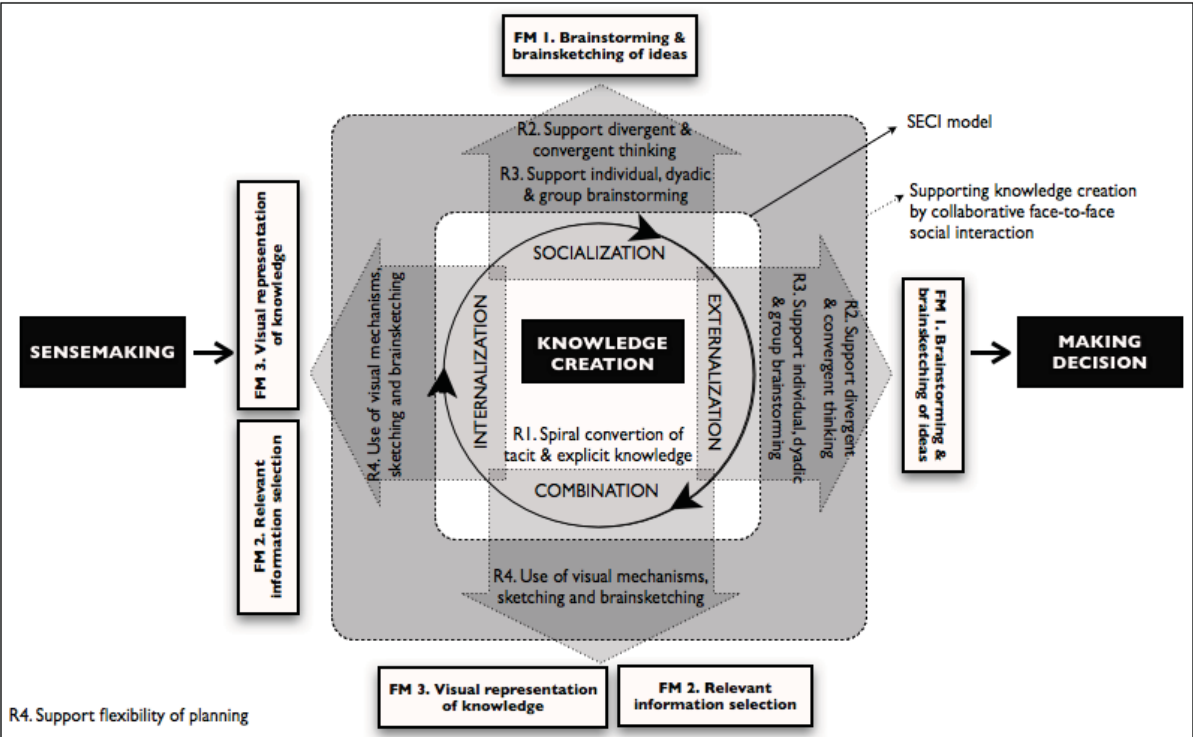
Figure 1. A conceptual model contextualizing the knowledge creation process support, based on the strategic role of information (sensemaking, knowledge creation and decision making). Each component of the SECI model is supported by requirements that support creativity, which are finally associated with the correspondent functional modes to be implemented on a software application supporting knowledge